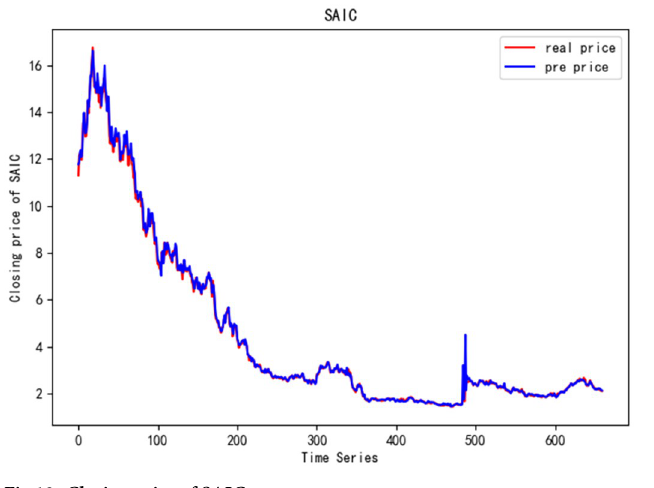
Fig 12. Closing price of